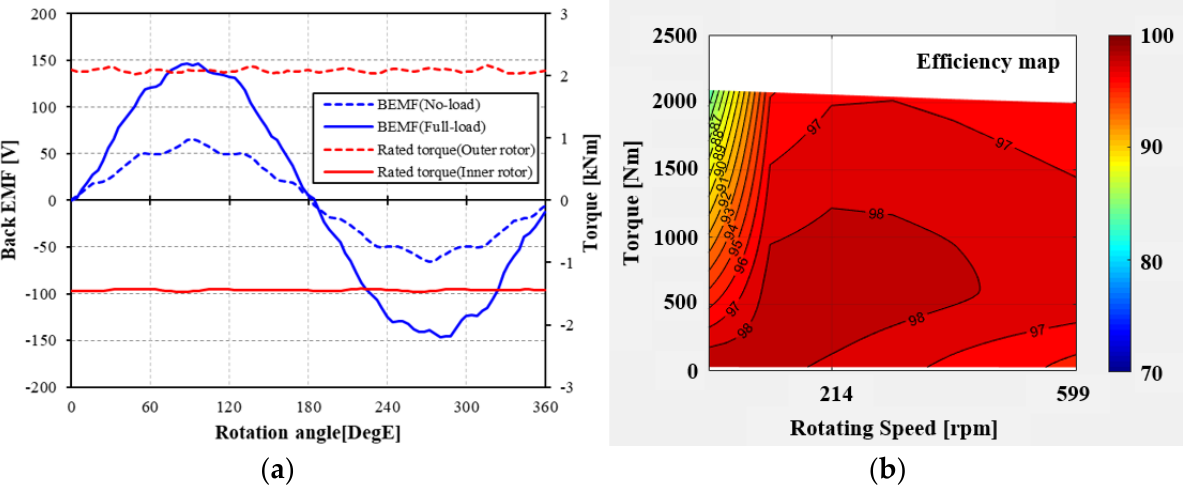
Figure 12. Performance characteristics of the final design model: ( a ) Back ‐ EMF and rated torque characteristics; ( b ) Torque and efficiency map. Table 6. Derivation results of the Detailed Design Model of 45kW ‐ class MG ‐ PMSM with Concentrated winding.